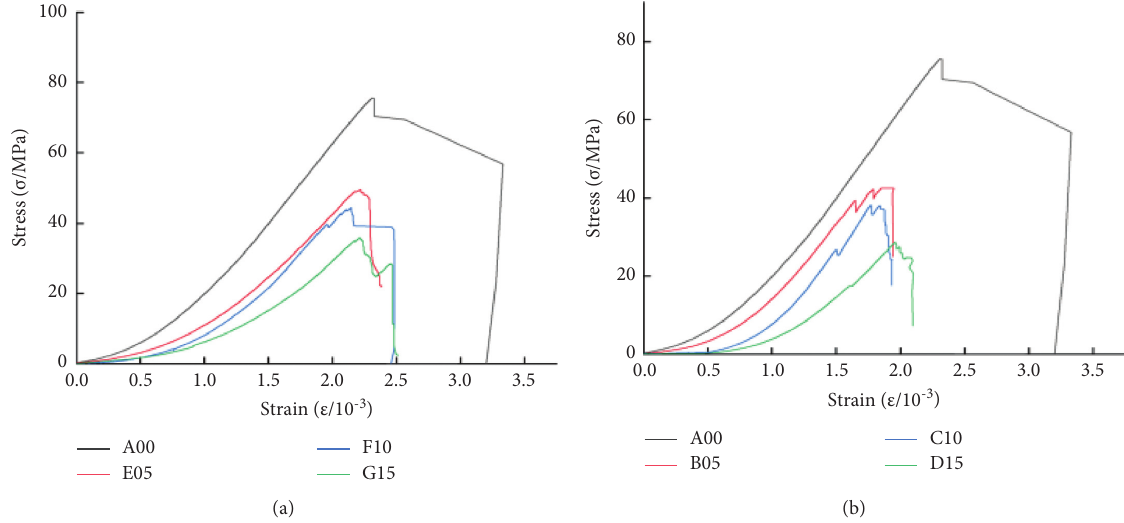
Figure 3: Stress-strain curves of the rock with different diameters of the hole. (a) Stress-strain curves of the rock with different diameters. (b) Stress-strain curves of the rock with different hole